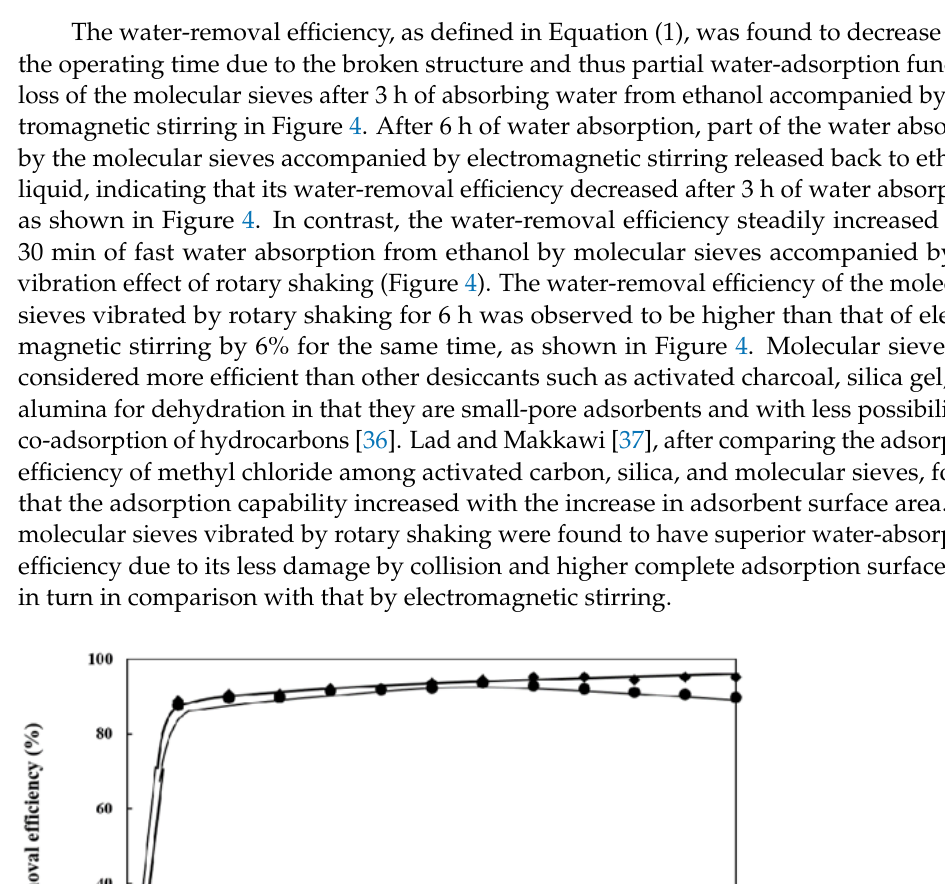
Figure 3. Comparison of the appearance of molecular sieves ( a ) before water absorption and ( b ) after water absorption from palm oil accompanied by rotary shaking.